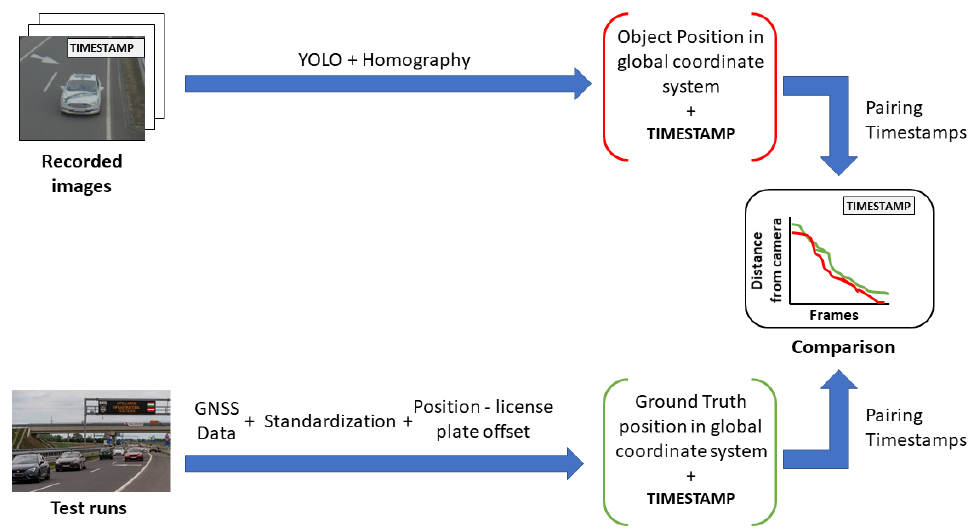
Figure 32. Evaluation process of homography-based object distance from infrastructure camera with ground truth